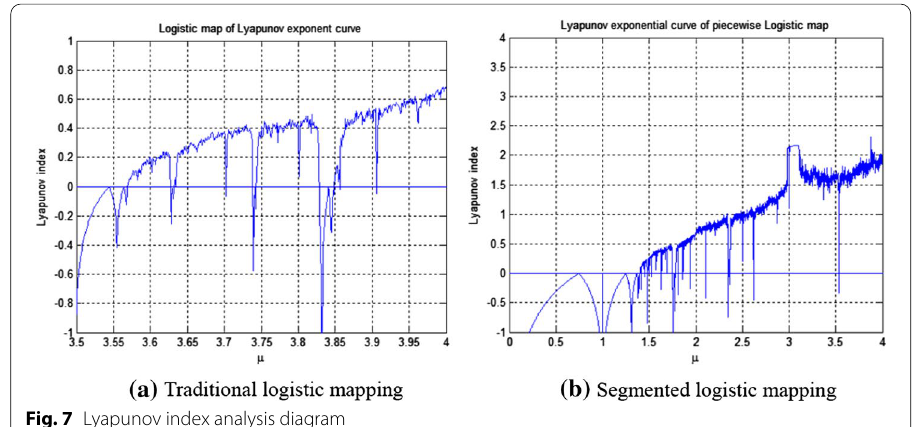
Fig. 7 Lyapunov index analysis